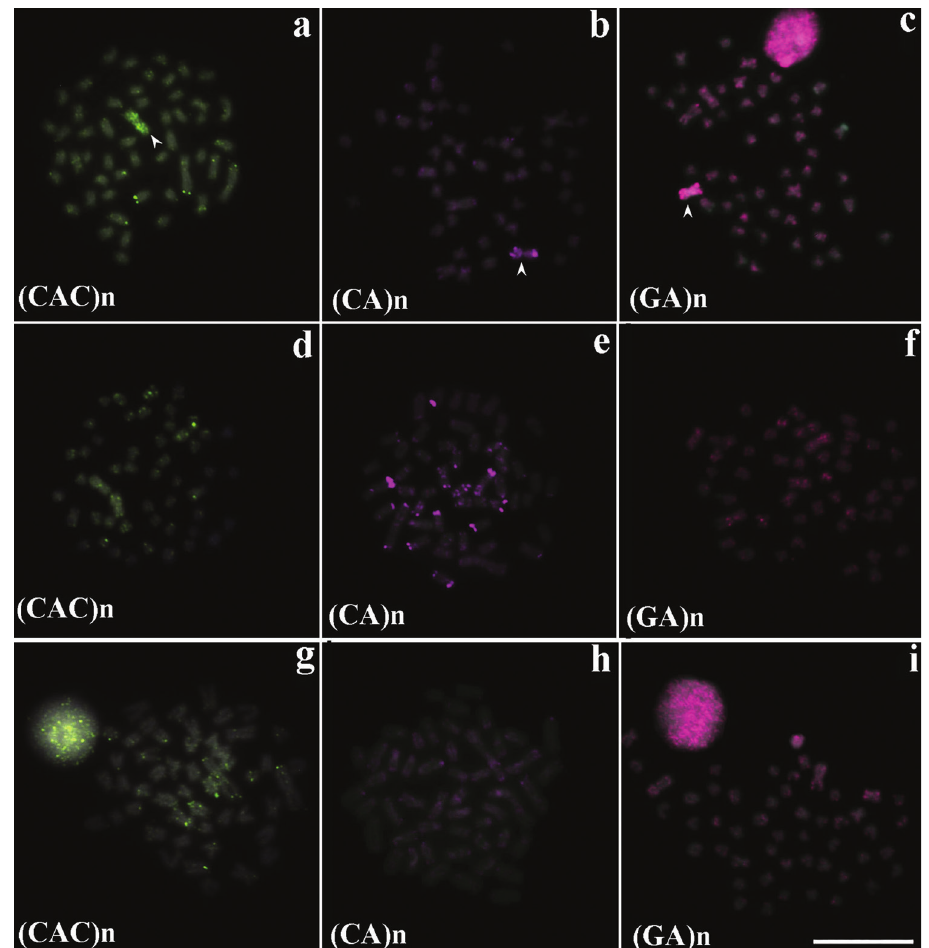
Figure 4. Fluorescence in situ Hybridization in metaphases of the three Astyanax scabripinnis populations ( a, b, c Lavrinha Farm Stream – LSF); ( d , e , f Lake of Pedalinho – LP); ( g, h, i Ribeirão das Perdizes - RP) with microsatellites probes. Scales bar: 10